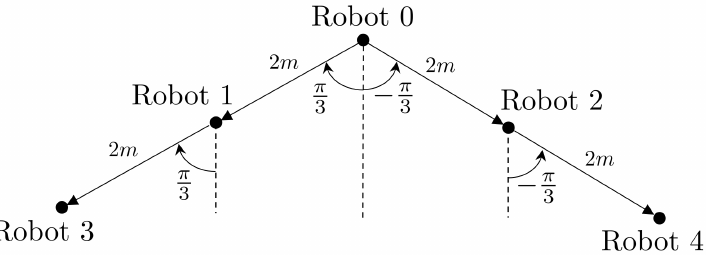
Figure 2. Desired formation and information